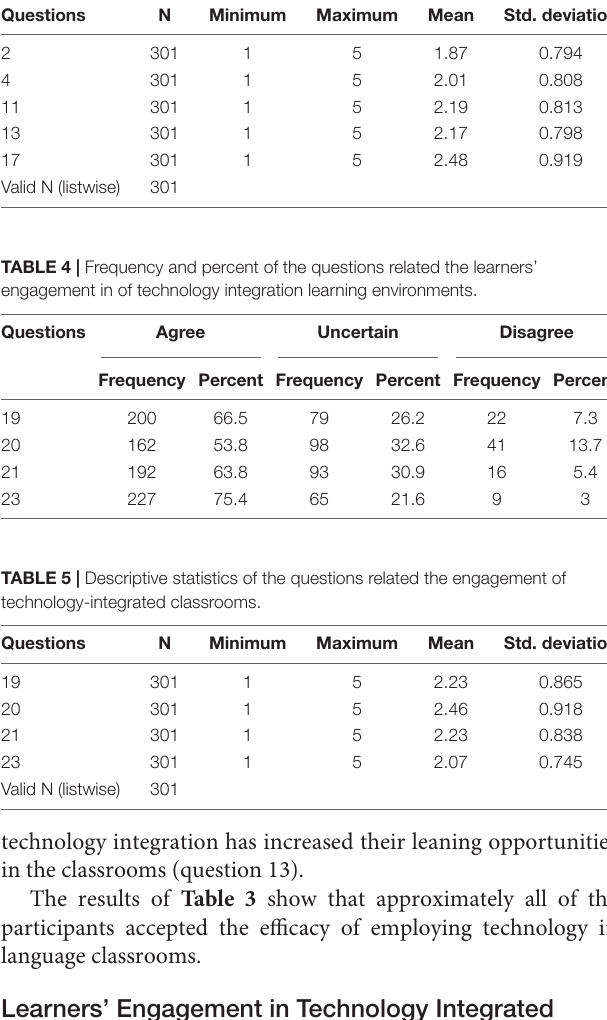
Table 4 indicates that the learners’ responses to the questions of 19, 20, 21, and 23 show that language learners agreed that integrating technology into their language classrooms increase their